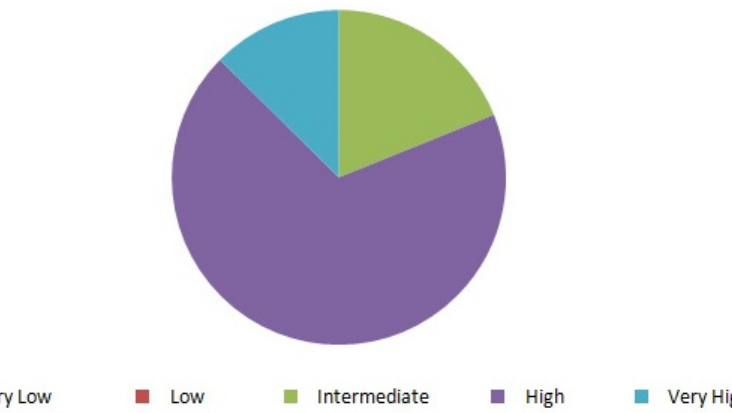
Figure 2. Evaluation of urological competences: objective questions.